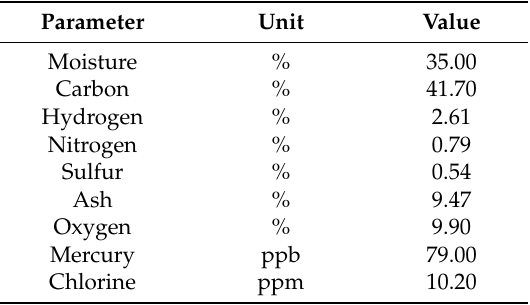
Table 1. Composition of Saskatchewan lignite coal